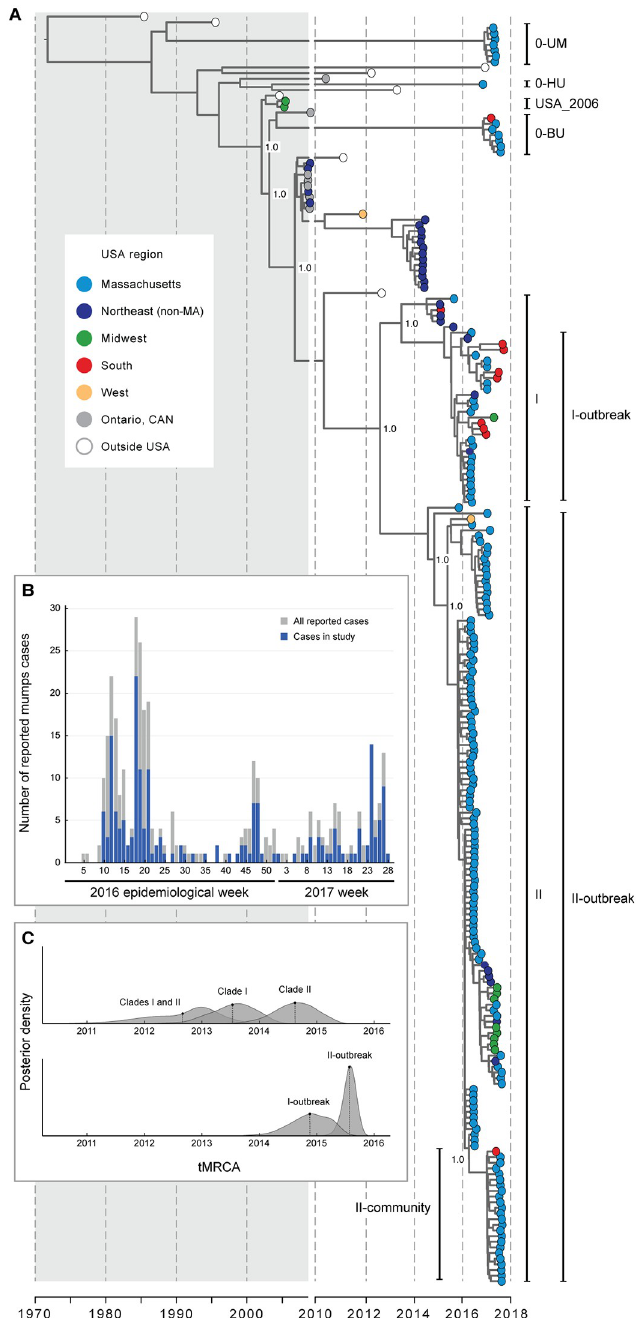
Fig 1. Massachusetts mumps outbreak overview. (A) Maximum clade credibility tree of 225 mumps virus genotype G whole genome sequences, including 200 generated in this study. Labels on internal nodes indicate posterior support. Clades I and II contain 91% of the samples from the 2016 and 2017 Massachusetts (MA) outbreak; I-outbreak and II- outbreak are the largest clades within them that contain only samples from the outbreak. Clade 0-UM contains samples associated with UMass other than those in Clades I and II; the same is true for 0-BU (BU) and 0-HU (Harvard). II-community contains primarily samples associated with a local Massachusetts community. (B) Number of reported mumps cases in 2016 by epidemiological week in Massachusetts (gray) and in this study (blue). (C) Probability distributions for the date of the most recent common ancestor (computed from tMRCA) of selected clades (see S2 Table for additional clades). Dotted line is the mean of each distribution. BU, Boston University; HU, Harvard Univeristy; tMRCA, time to the most recent common ancestor; UM, University of Massachusetts Amherst; UMass, University of Massachusetts